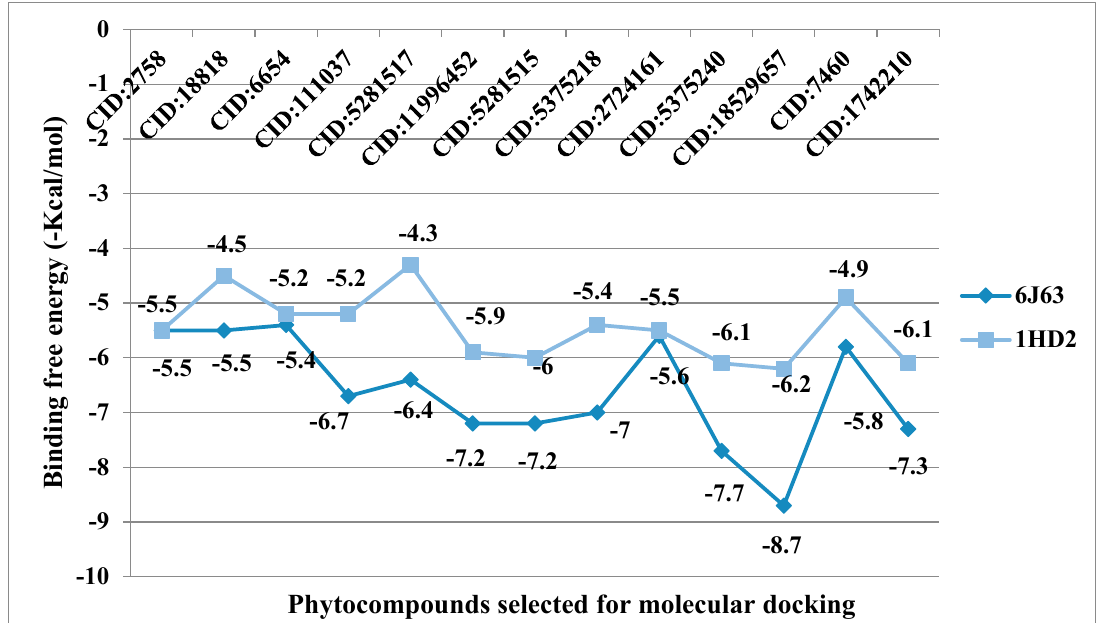
Figure 7. Binding energy ( − kcal/mol) of selected phytocompounds from VAO, VNO, and VTO, com- plexed with 6J63 and 1HD2.